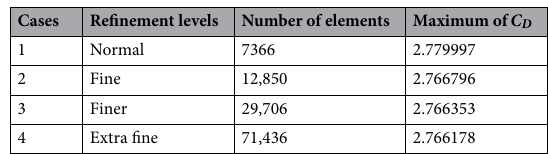
Table 2. Test for grid independence using an attached splitter plate to the circular